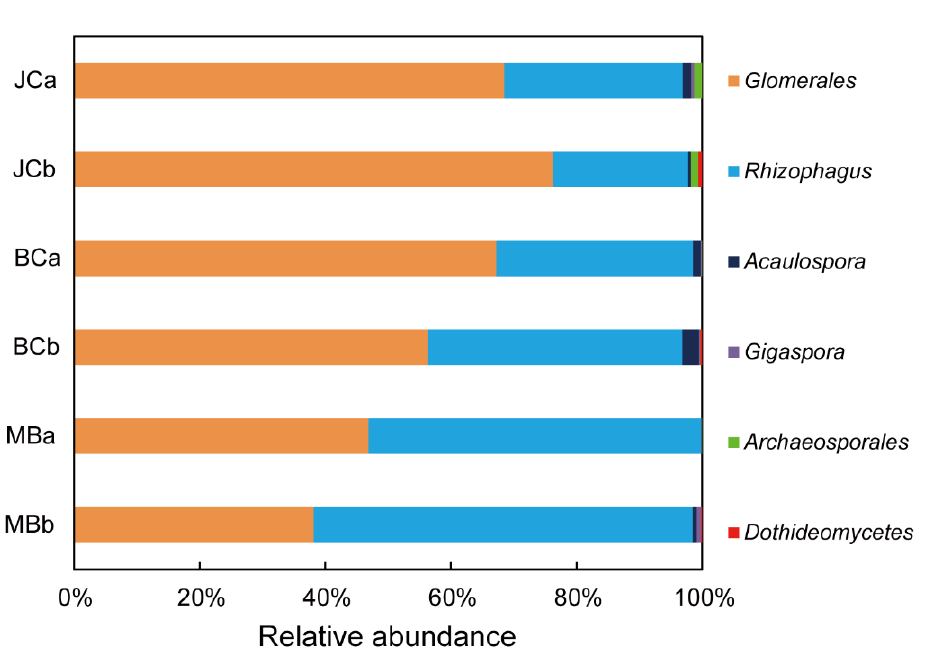
Table 3. The contributions of soil chemical properties to the variation of AMF community.